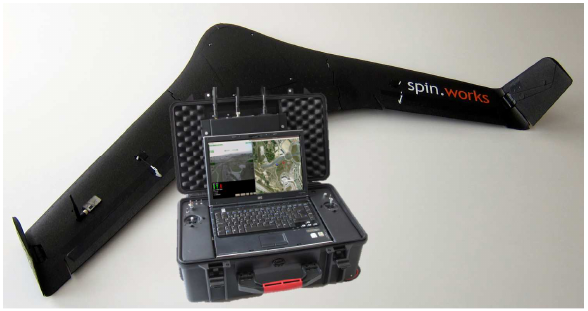
Figure 1: Spin.Works S-20